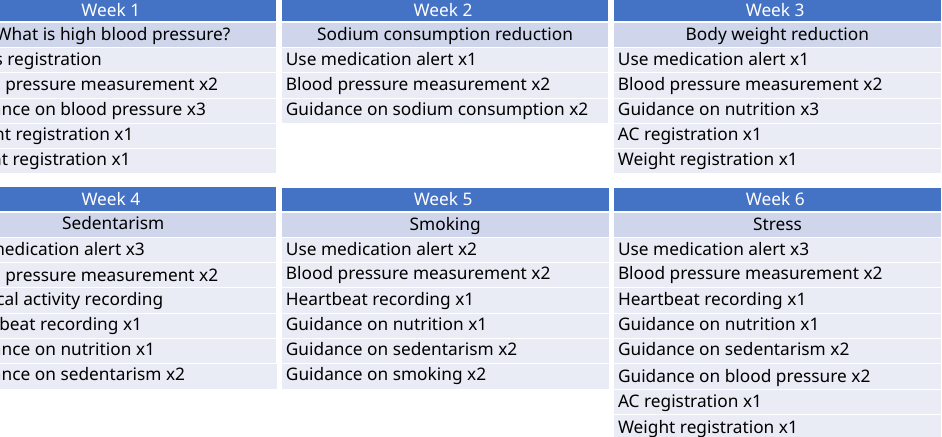
Figure 14. Health goals by week and